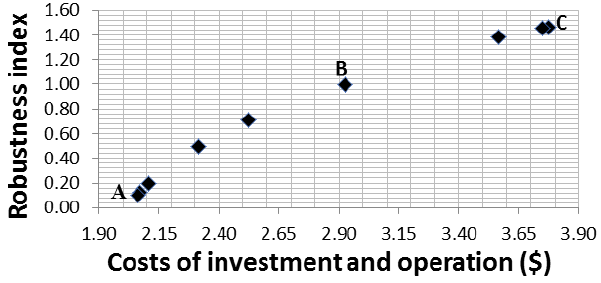
Figure 4. Frontier obtained: Case IV (values: 10 6